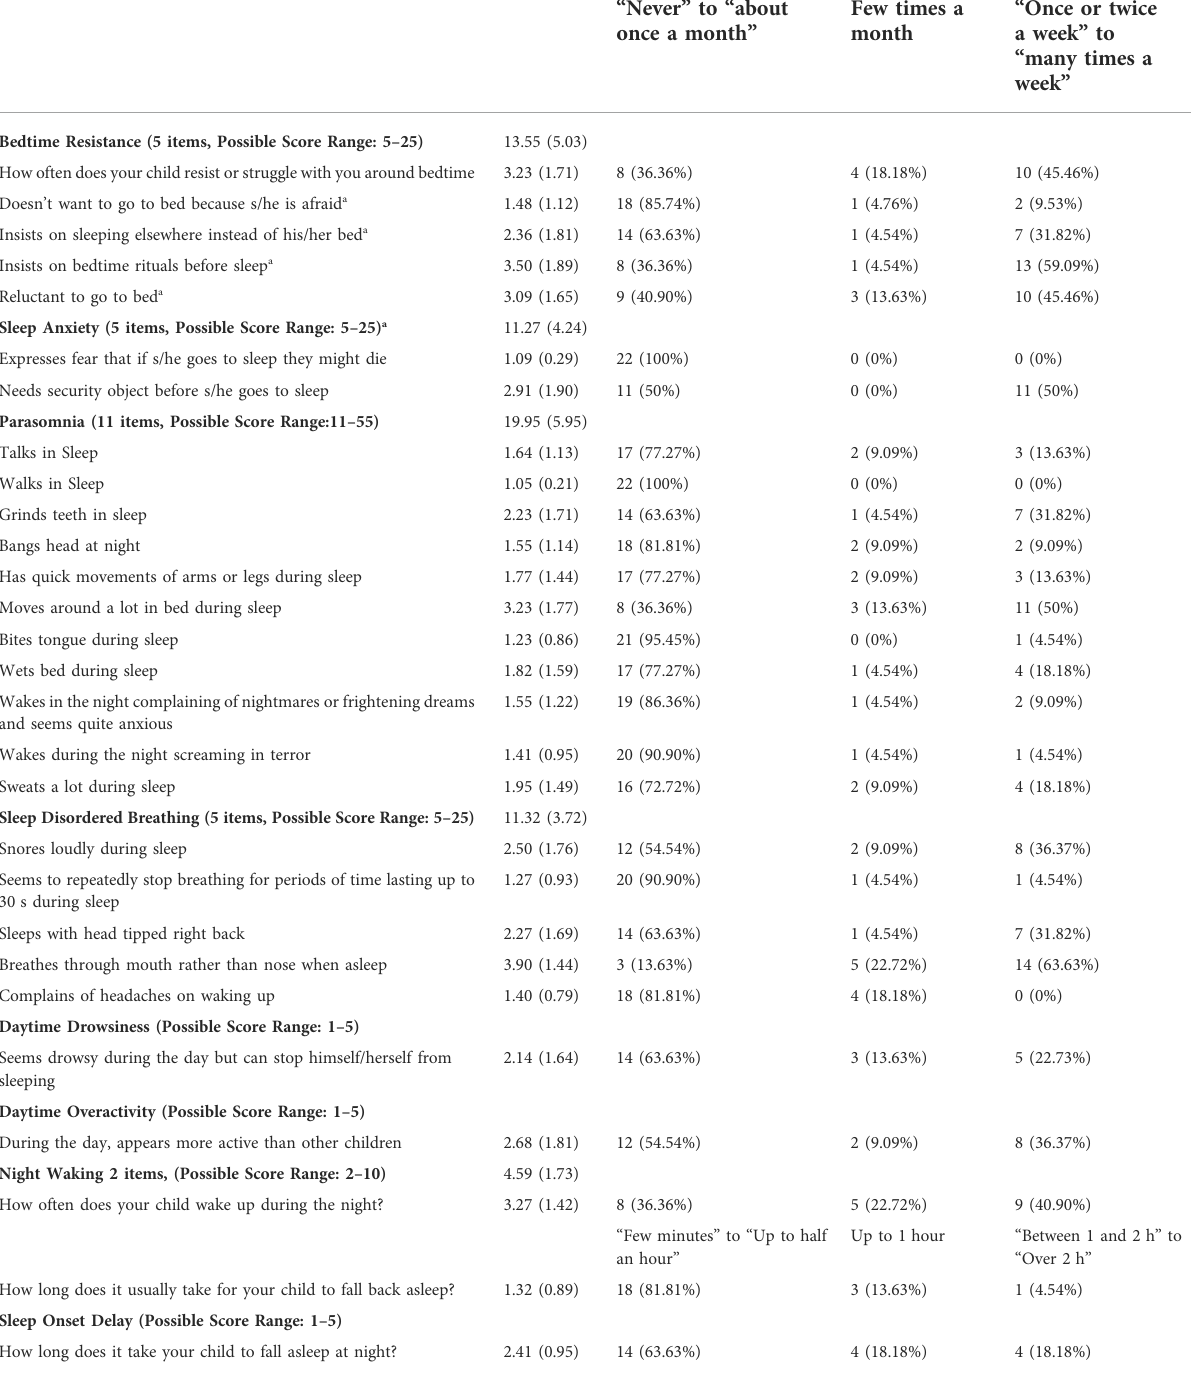
Mean Proportion of sample endorsing sleep symptoms (SD) “ Never ” to “ about once a month ”